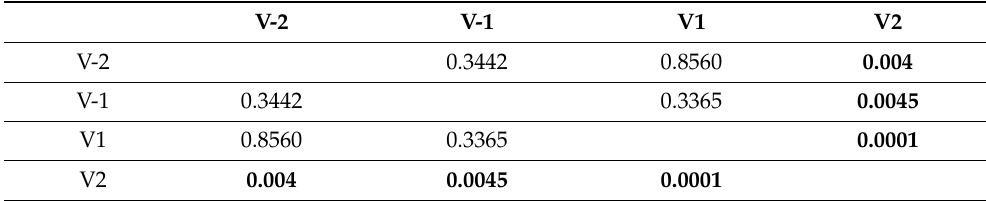
Table 4. Post-hoc analysis of average central retinal thickness during follow-up of aflibercept compar- isons in